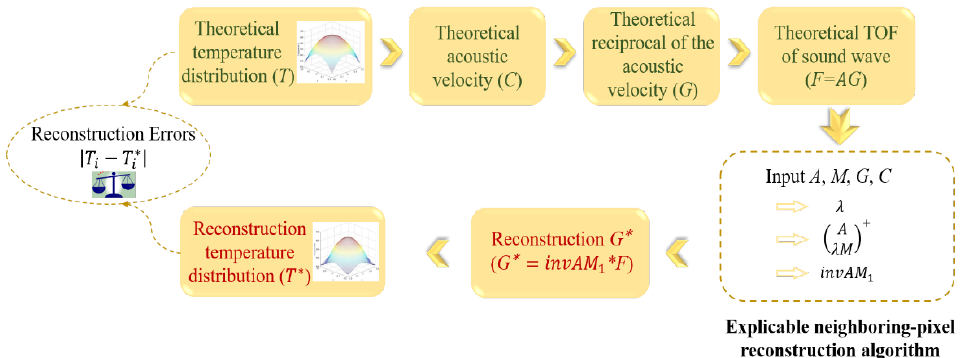
Figure 1. The flow of the acoustic tomography. T, C, G mean the theoretical parameters, and T*, G* mean the reconstruction values obtained via the reconstruction algorithm. Finally, we calculate a series of errors between T and T* to evaluate our proposed image reconstruction method.